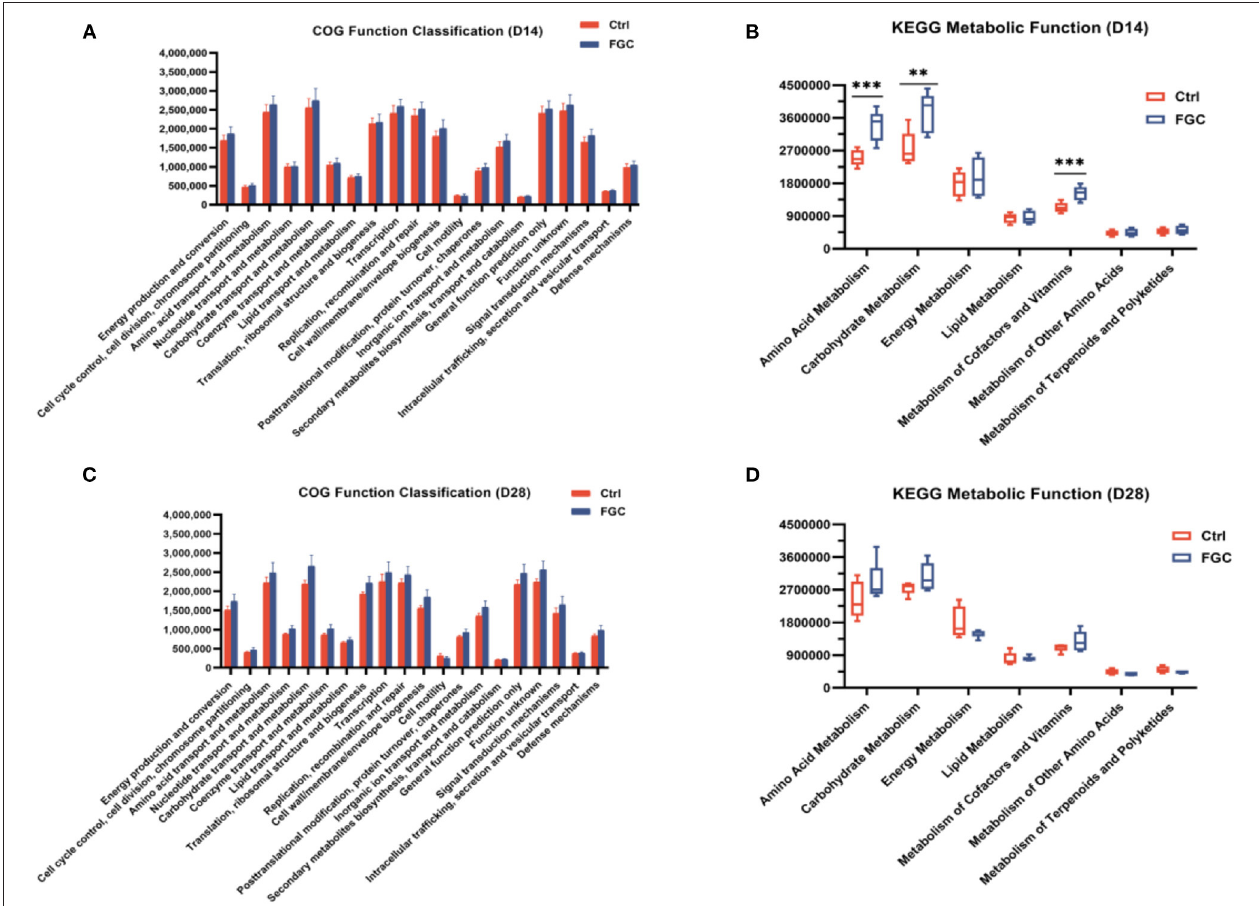
FIGURE 10 | Predictive functional analysis of fecal microbiota in 14d and 28d-piglets. (A) COG function classification of 14d-piglets (B) KEGG metabolic function of 14d-piglets at pathway level 2. (C) COG function classification of 28d-piglets (D) KEGG metabolic function of 28d-piglets at pathway level 2. COG, Clusters of Orthologous Groups; KEGG, Kyoto Encyclopedia of Genes and Genomes. Ctrl, corn-soybean basal diet; FGC, corn-soybean basal diet with 2,000 mg/kg ferrous glycine chelate. Data were shown as means ± SEM. ** p < 0.01; *** p < 0.001. N =